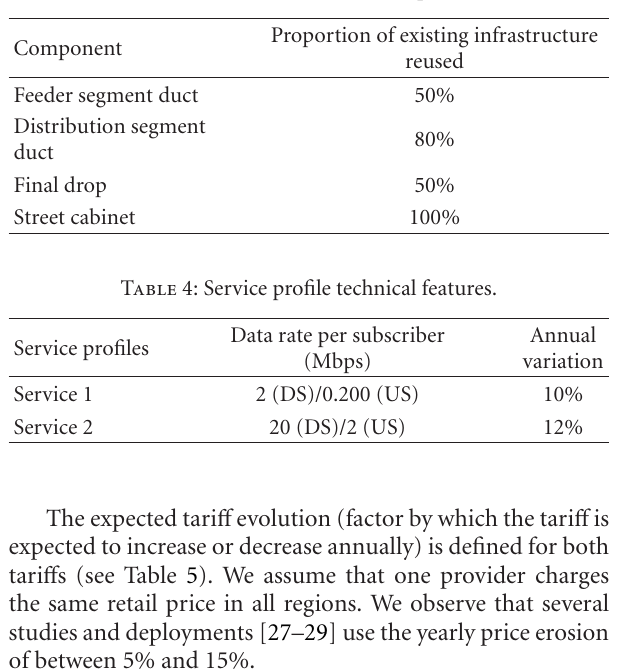
Table 3: Infrastructure reuse assumptions [18].